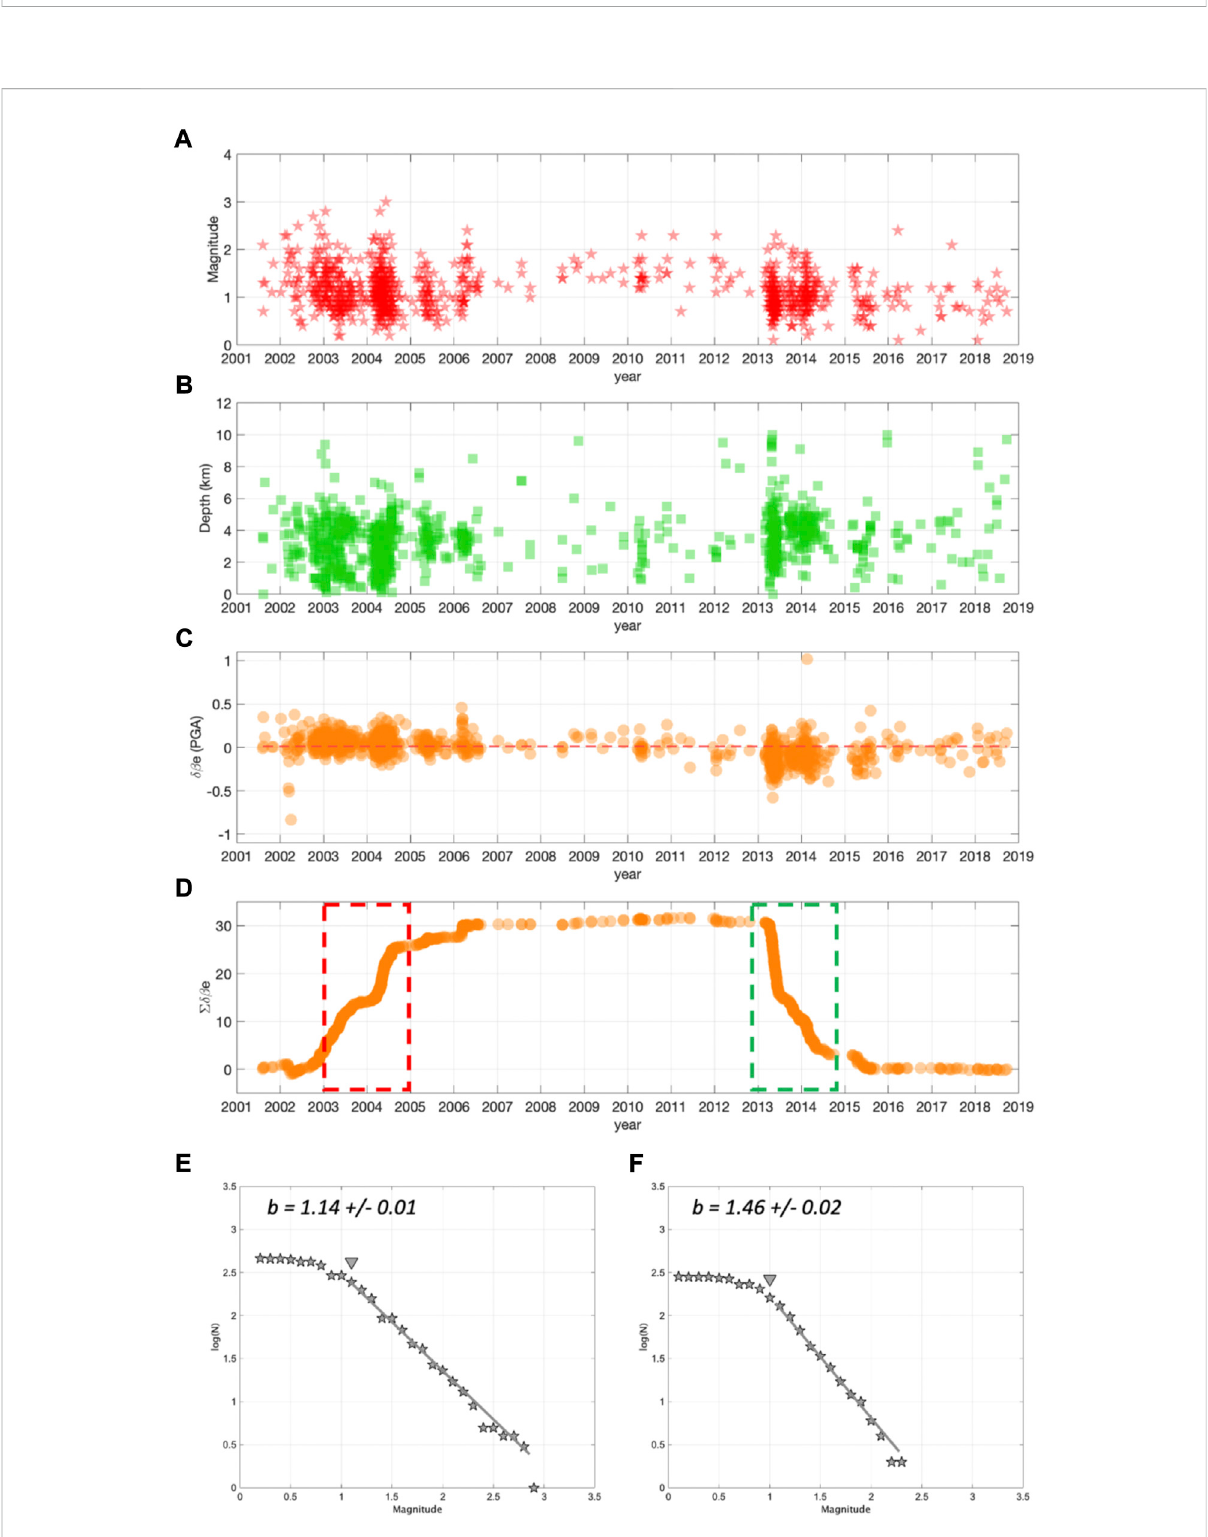
FIGURE 3 (Continued) eventresiduals( δ Be)distributionandmedianvalues(reddashedline). (C) δ Be versus Mw;median(redsquares)andstandarddeviation(redlines) of ( δ Be), computed for bins of the values of hypocentral